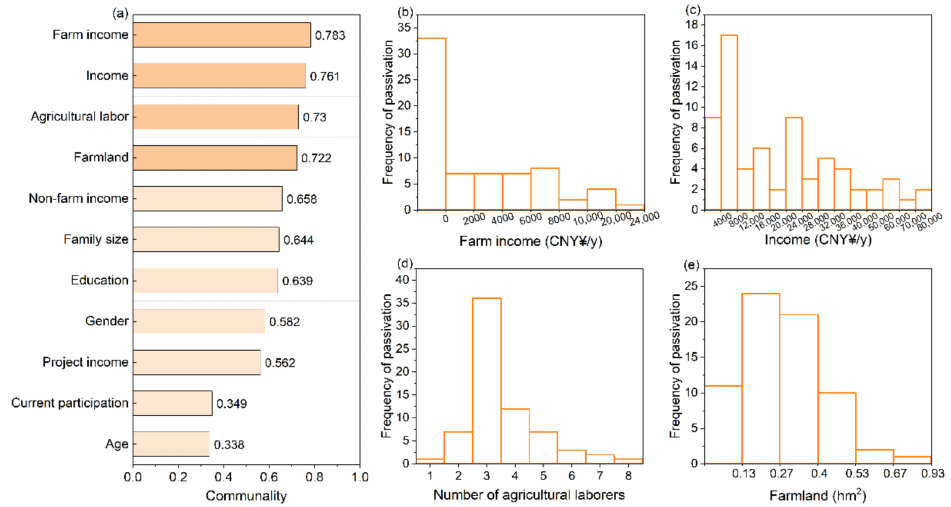
Figure 8. Characteristics of farmers intended for passivation. ( a ) communality of characteristics of farmers intended for passivation extracted by PCA. The dark yellow, communality > 0.7. Frequency distribution of ( b ) farm income, ( c ) income, ( d ) agricultural labor, and ( e ) farmland of farmers who chose